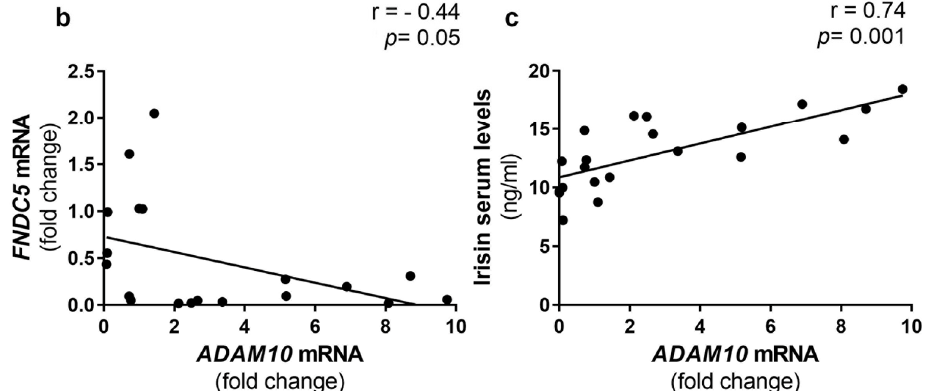
Figure 4. Quantitative PCR (qPCR) showing mRNA expression levels of ADAM10 in muscle biopsies of control subjects (CTRL) and DM and IMNM patients. Gene expression was normalized to the mean of housekeeping genes ( GAPDH and B2M ) and plotted as fold increase from CTRL ( a ). D’Agostino and Pearson normality test and Kruskal–Wallis test with two-group comparison by Dunn’s multiple comparisons test were performed. Data are presented as box-and-whisker plot with median and interquartile ranges from max to min with all data points shown; significant results were indicated by p value. FNDC5 mRNA levels negatively correlated with ADAM10 mRNA levels ( b .) Irisin serum levels are positively associated with ADAM10 mRNA levels ( c ). For linear regression, r and p values are as indicated.